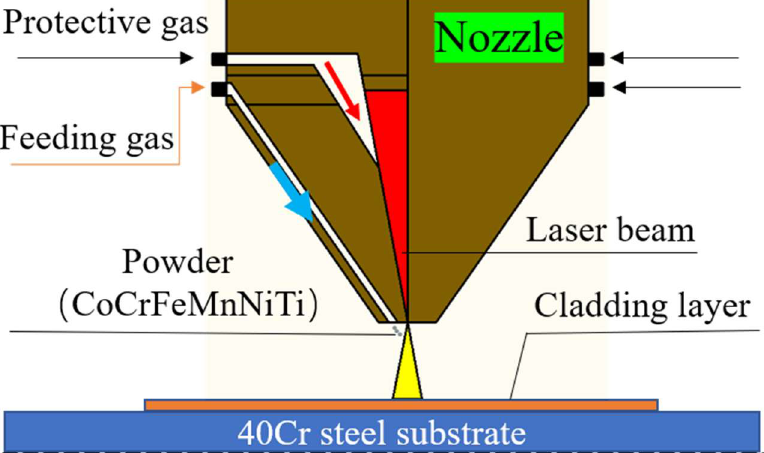
Figure 2. Diagram of the working principle of the laser head.